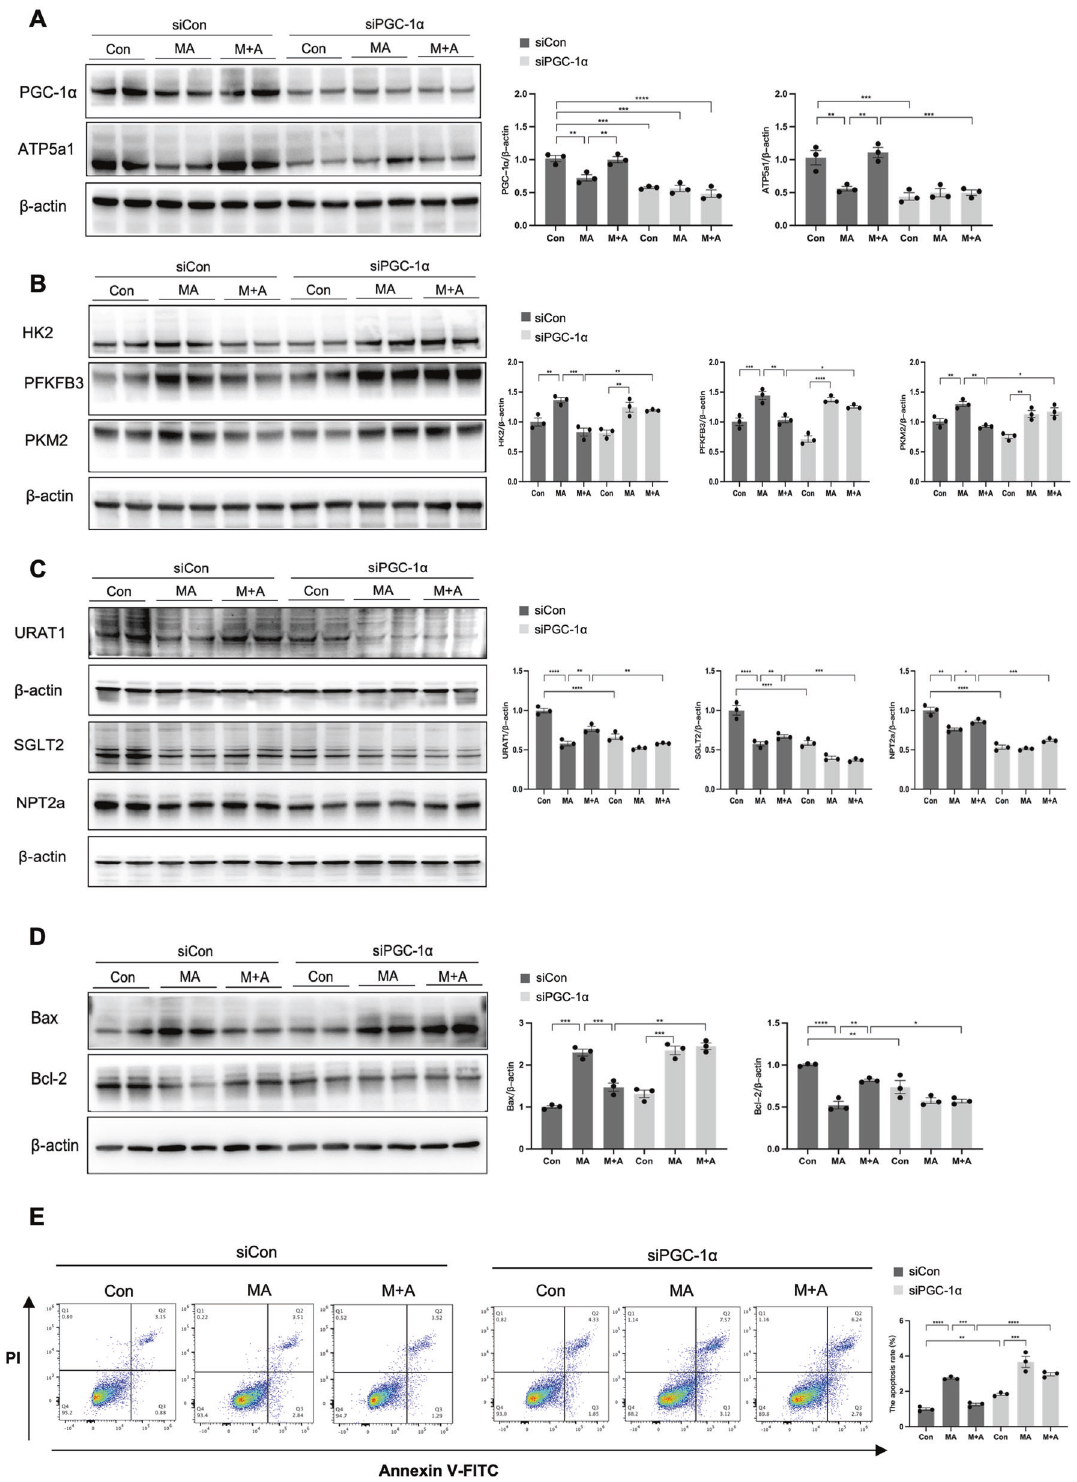
Fig. 8 Knockdown of PGC-1 α abrogates the improvement of ALDH2 activation on mitochondria, tubular transporter disorder and cell apoptosis in HK-2 cells. HK2cellsweretransfectedwith controlsiRNAorPGC-1 α siRNAfor6h andtreatedwithMAinthe presenceorabsenceofAlda- 1 for 24h. A The expression of mitochondria-related proteins (PGC-1 α and ATP5a1) was measured by western blotting ( n = 3). B The expression of aerobic glycolysis-related enzymes (HK2, PFKFB3 and PKM2) was measured by western blotting ( n = 3). C The expression of tubular transporter proteins (SGLT2, NPT2a and URAT1) was measured by western blotting ( n = 3). D The expression of apoptosis-related proteins (Bax and Bcl-2) was measured by western blotting ( n = 3). E Apoptosis was determined by fl ow cytometry in 6 groups ( n = 3). * P <0.05, ** P <0.01, *** P <0.001, **** P <0.0001, ns not signi fi cant. (Con Control, MA maleic acid, M + A maleic acid + Alda-1, siCon control siRNA, siPGC-1 α PGC-1 α siRNA, PI propidium iodide).